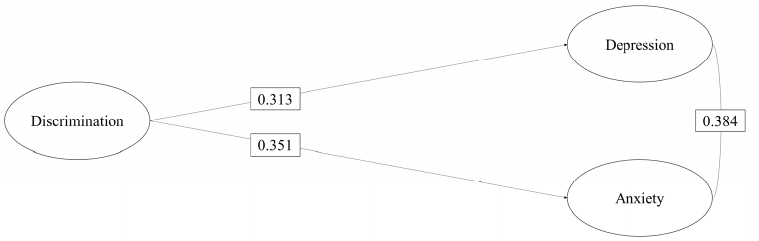
Figure 3. Model of the effect of discrimination on depression and anxiety. All estimated indirect effects were statistically significant ( p < 0.05).